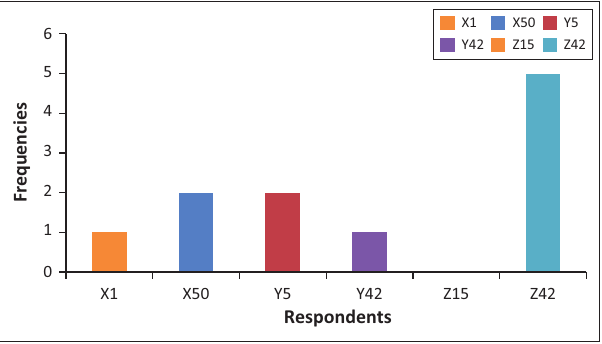
FIGURE 2: Respondents’ frequencies of spelling orthographic errors ( N = 6).